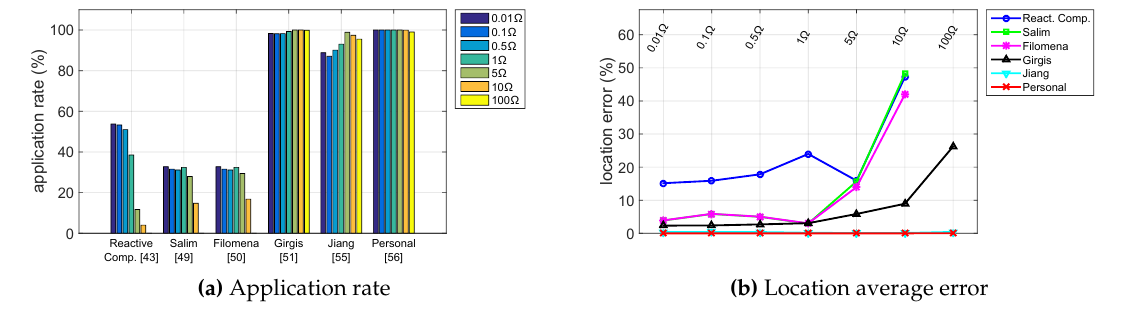
Figure 16. Line-to-sheath resistance analysis.